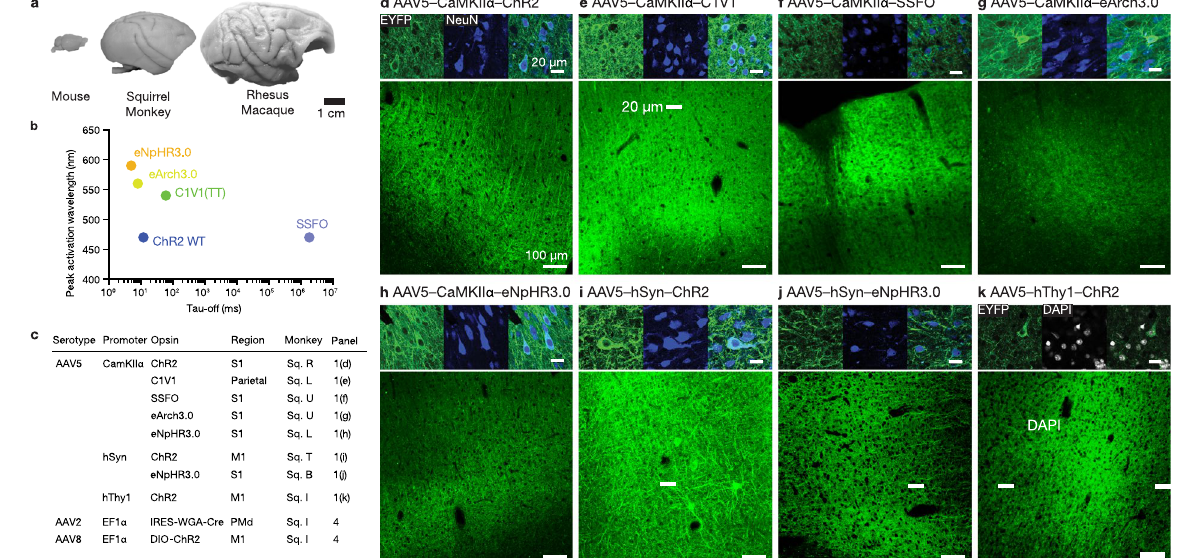
Figure 1. AAV5 successfully transfects cortical neurons in squirrel monkeys. ( a ) Macroscopic image of squirrel monkey brain versus mouse and rhesus macaque brain. ( b ) Opsins were tested across a wide range of opsin deactivation kinetics ( τ off ) and activation wavelengths, based on 40,43 . ( c ) Table of opsins successfully transfected, listed by viral serotype, promoter opsin, brain region, and subject identifier. For a full table, see Supp. Table 1. ( d – k ) Representative histology for first 8 opsins in table (see Fig. 4 for projection targeting constructs). 40x images show EYFP fluorescence in green, DAPI stain in white or NeuN stain in blue, and merged; scale bars 20 μ m. 10x images from coronal slices depict EYFP fluorescence in green at injection site; scale bars 100 μ m. We note that in Fig. 1i, the unusually large expressing neurons are Betz cells from layer V of primary motor cortex.